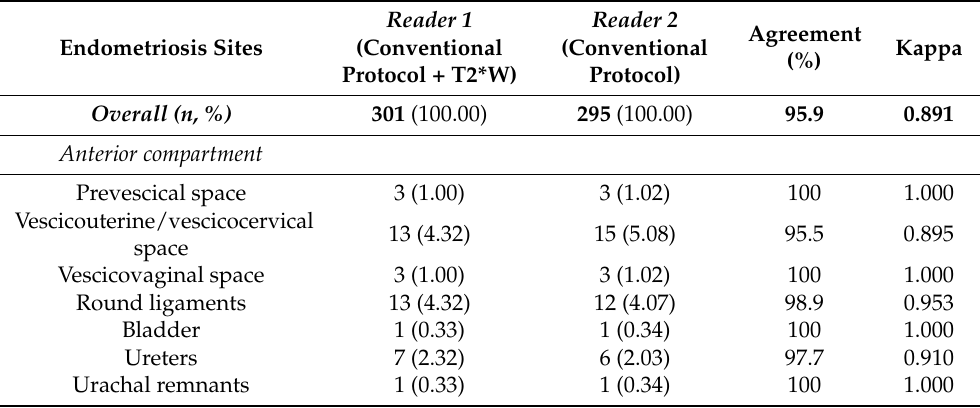
Figure 1. Signal voids consistent with deep endometriosis foci. ( a , b ): 27-year-old patient with endometriosis involving the right fallopian tube. T2*W sequence shows a signal void (yellow arrow) seen as a corresponding tiny hyperintense endometriotic haemorrhagic focus on T1W fat sat image (white arrow); ( c , d ): 38-year-old patient with anterior vaginal fornix endometriosis visible as a T2*W dark lesion (yellow arrowhead) and as a bright spot on the T1W image (white arrowhead), with the same clinical significance. Table 4. Comparison between MRI findings detected on the conventional protocol with the addition of T2*W imaging ( Reader 1 ) and only on the conventional protocol ( Reader 2